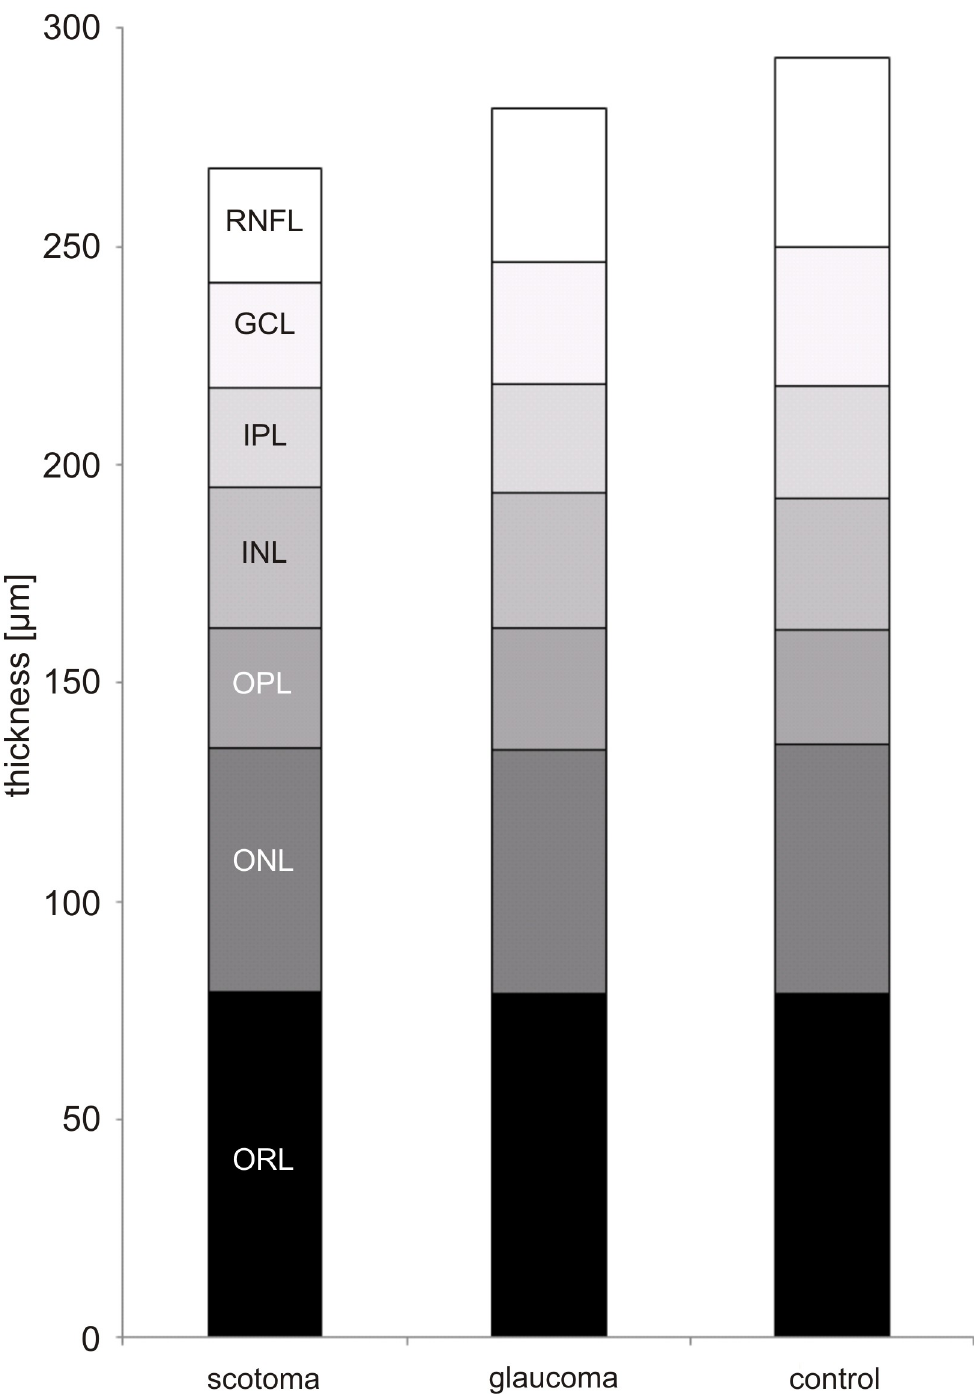
Fig 5. Summary of mean thickness values. Graphical representation of the seven retinal layers measured in the glaucoma eyes with the absolute visual field scotoma (scotoma), the contralateral eyes of the glaucoma patients (glaucoma) and the healthy control group depicted as stacked box plot which shows decreased layer thicknesses for RNFL, GCL and IPL but not for the four outer retinal layers.